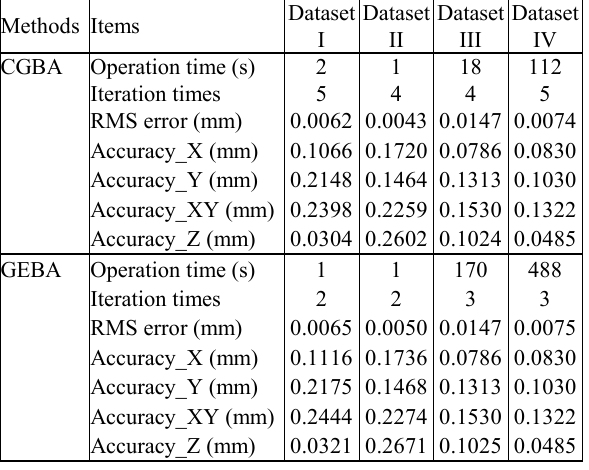
Table 2. Experimental results of improved CGBA and